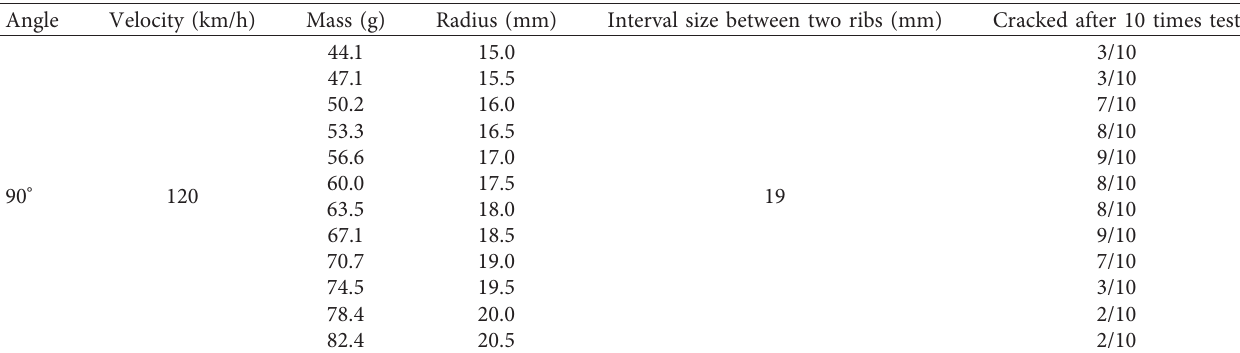
Table 4: Test results III.